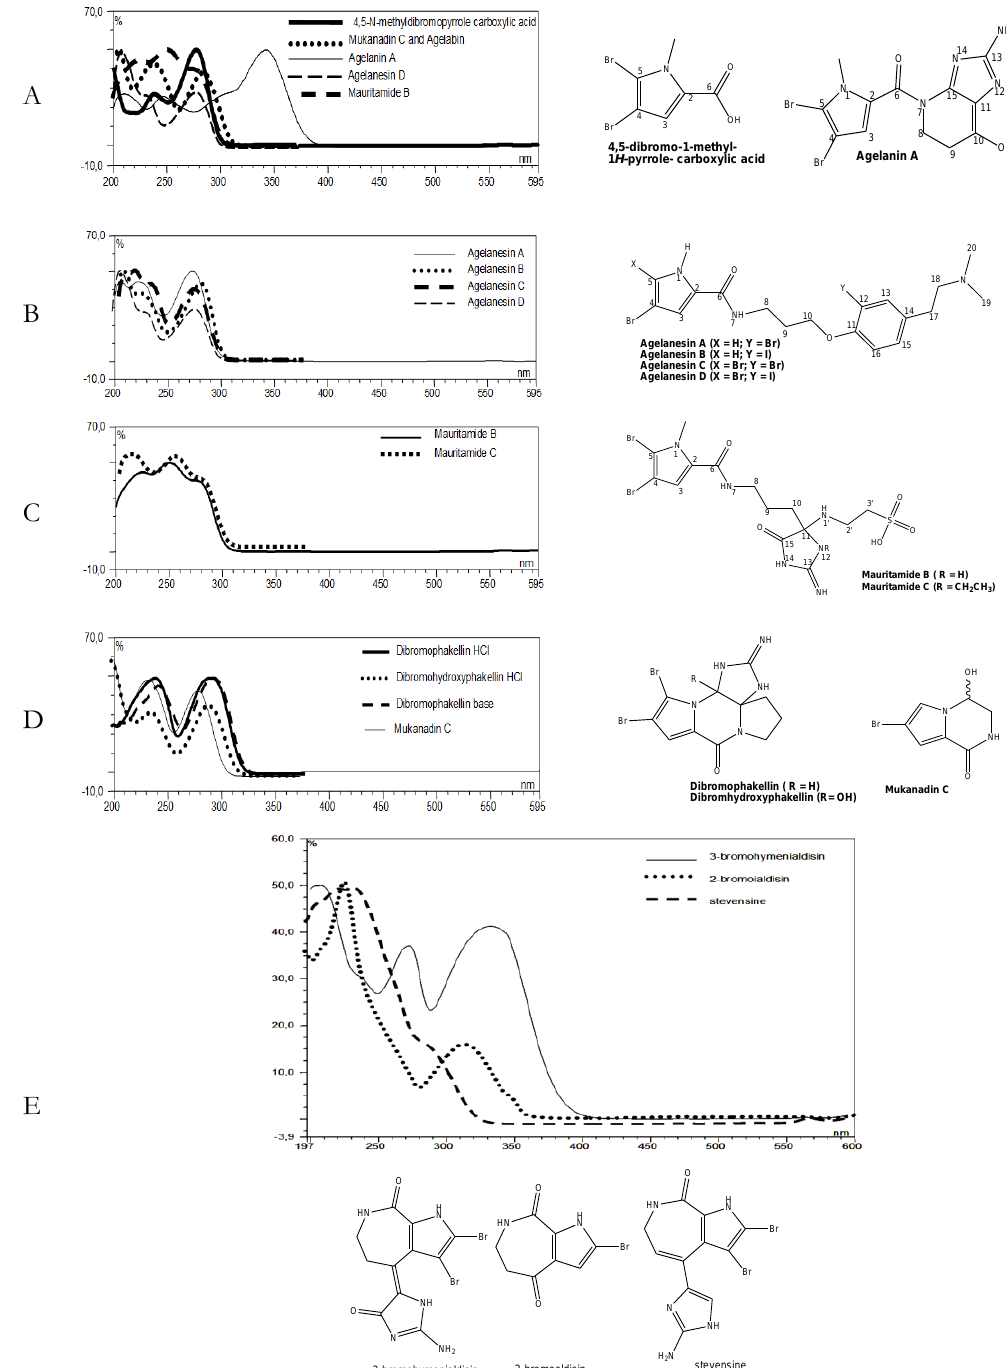
Figure 3. UV absorption pattern of several pyrrole imidazole alkaloids. Note: a-d are from Agelas linnaei and Agelas nakamurai (Hertiani, 2007); e was modified from Baker, 2004; Pedradab,